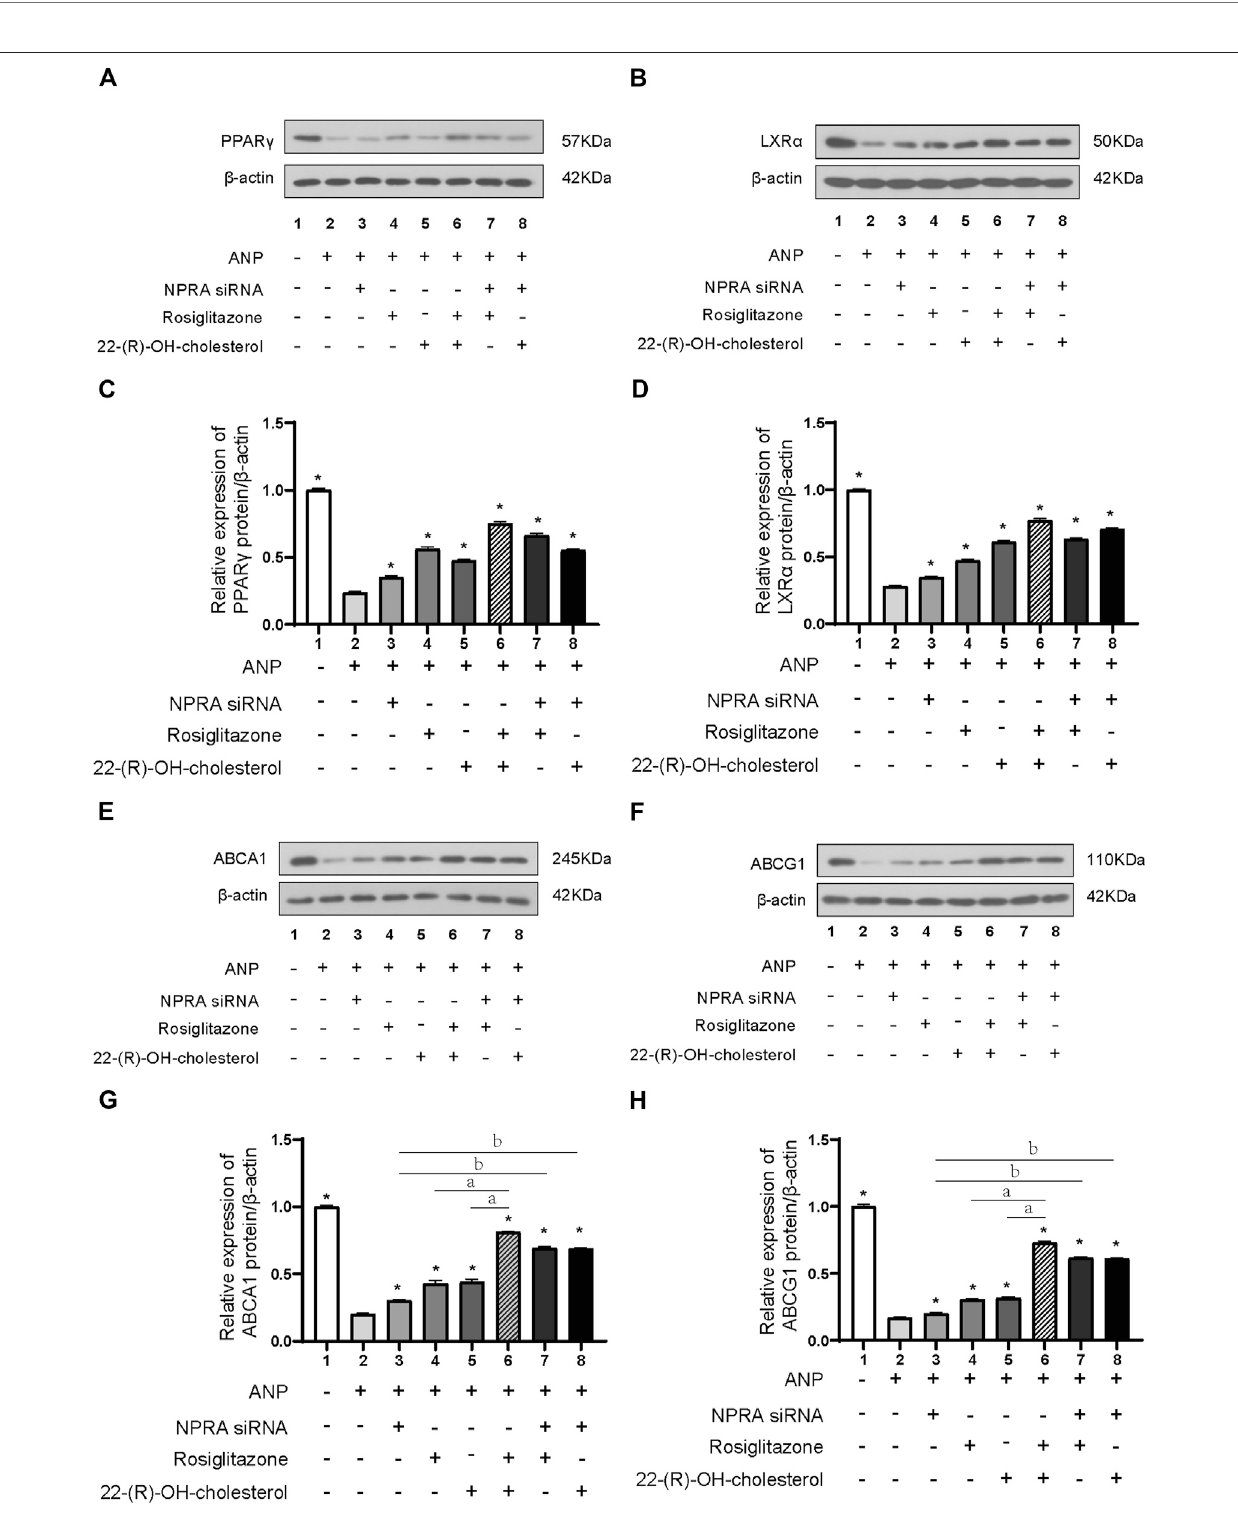
FIGURE 4 | ANP inhibited the expression of ABCA1 and ABCG1 through the PPAR γ /LXR α pathway. THP-1 cells were transfected with or without NPR-A siRNA andpretreatedwithorwithoutANP(10 − 5 mol/L)for72h,andthenincubatedwithorwithoutrosiglitazone(100 nM)or22-(R)-OH-cholesterol(1 μ M)foranother24 h.The protein expressions of PPAR γ (A) , LXR α (B) , ABCA1 (E), and ABCG1 (H) were examined by Western immunoblotting assays. β -actin was used as an endogenous control. The protein expressions of PPAR γ (C) , LXR α (D) , ABCA1 (G) , and ABCG1 (H) were quanti fi ed by densitometric analysis of Western immunoblotting. *p < 0.01vs.theANPalonegroup. a P < 0.01vs.theANP+rosiglitazone+22-(R)-OH-cholesterolgroup. b P < 0.01vs.theANP+NPR-A siRNAgroup.Dataareexpressedas mean ± SEM of three independent